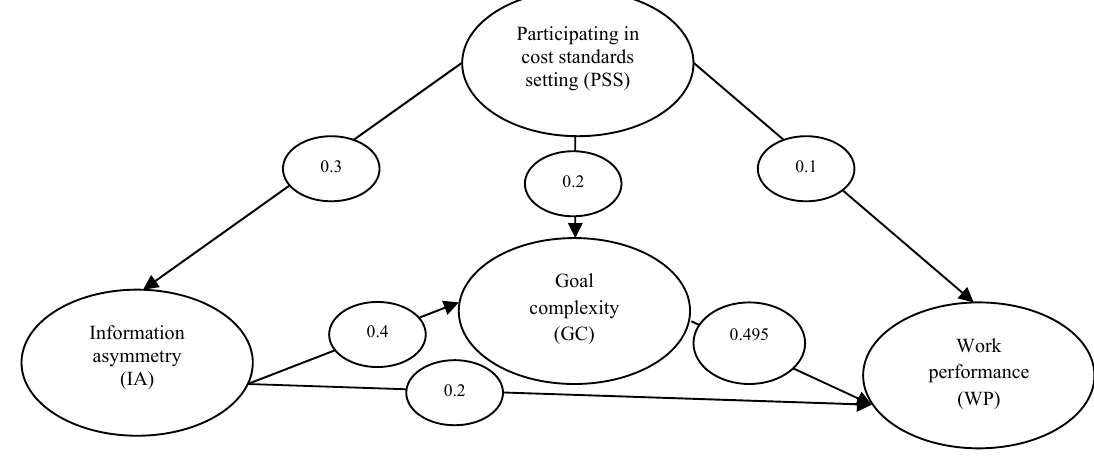
Fig. 2. direct effect of path